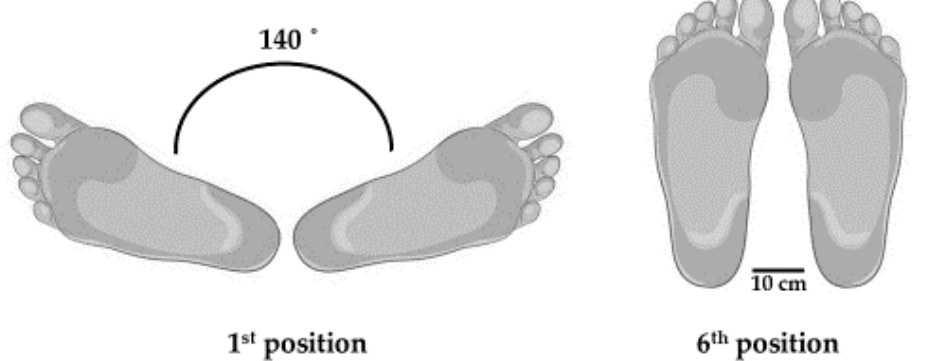
Figure 1. Visual depiction of both 6th and 1st positions used during balance tests. Note: if unipedal, the participant’s single foot serving as the base was still at the same position as shown above as the sole base of support.